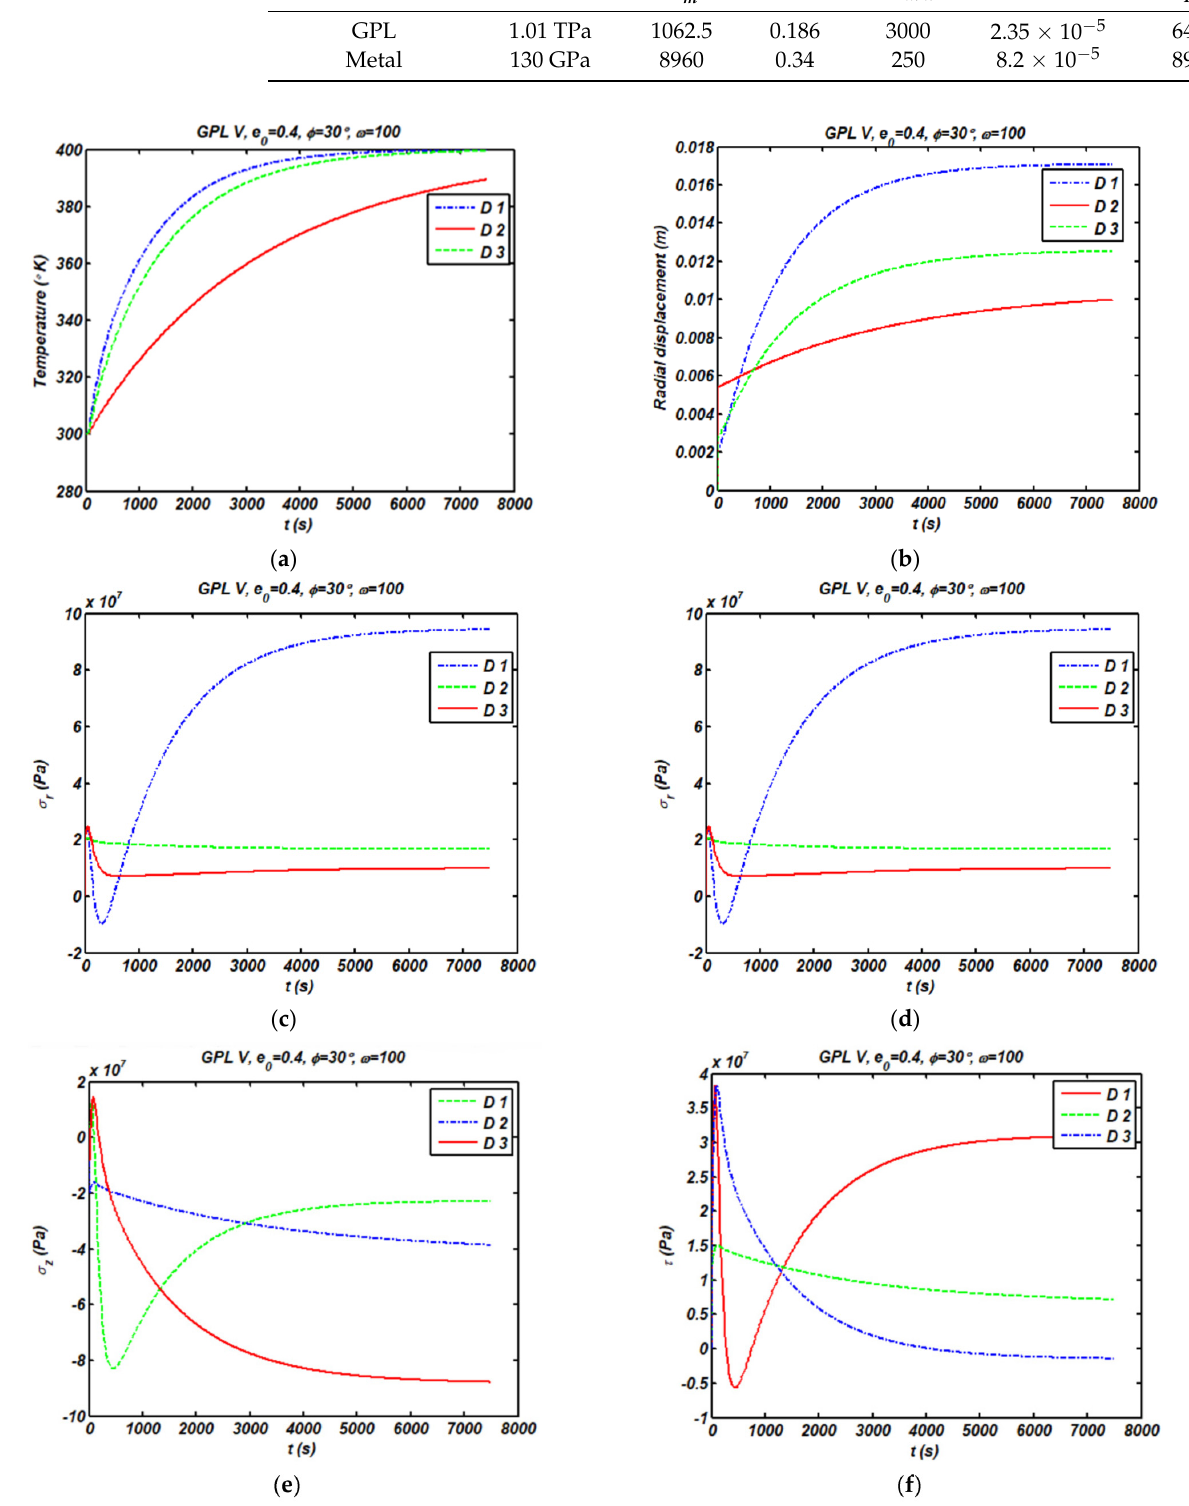
Figure 4. Influence of porosity distribution on the transient temperature ( a ), radial displacement ( b ), and stress state ( c – f ) for center point of truncated cone (GPL V; e 0 = 0.4; φ = 30 ◦ ; γ GPL = 0.01; ω = 100